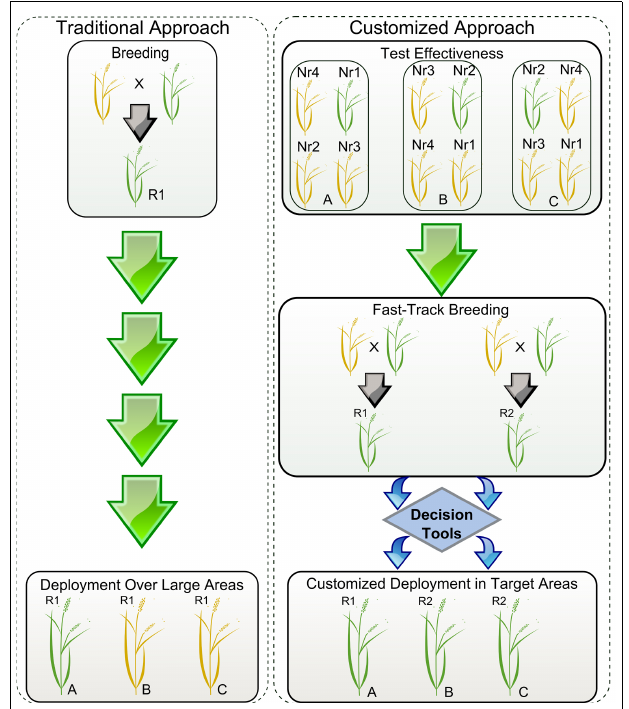
FIGURE 1 | Simplified scheme showing the deployment of resistant varieties using traditional versus customized approaches. R1 and R2 represent resistant elite varieties carrying hypothetical genes 1 and 2. Yellow and green plants represent susceptible and resistant phenotypes, respectively. Locations A, B, and C represent cropping regions that do not share boundaries. Nr1, Nr2, Nr3, and Nr4 are near-isogenic lines (NILs) for each of the available resistance genes 1, 2, 3, and 4. During traditional deployment, variety R1 is bred and released in large areas but is effective only in particular locations. During customized deployment, the effectiveness of the resistance genes and pathogen population structures are monitored using disease hotspots, seasonal collections, and pathogenicity tests done in a confined setting. Using a decision tool, breeding programs can rapidly customize the elite varieties to be deployed in targeted locations based on variety